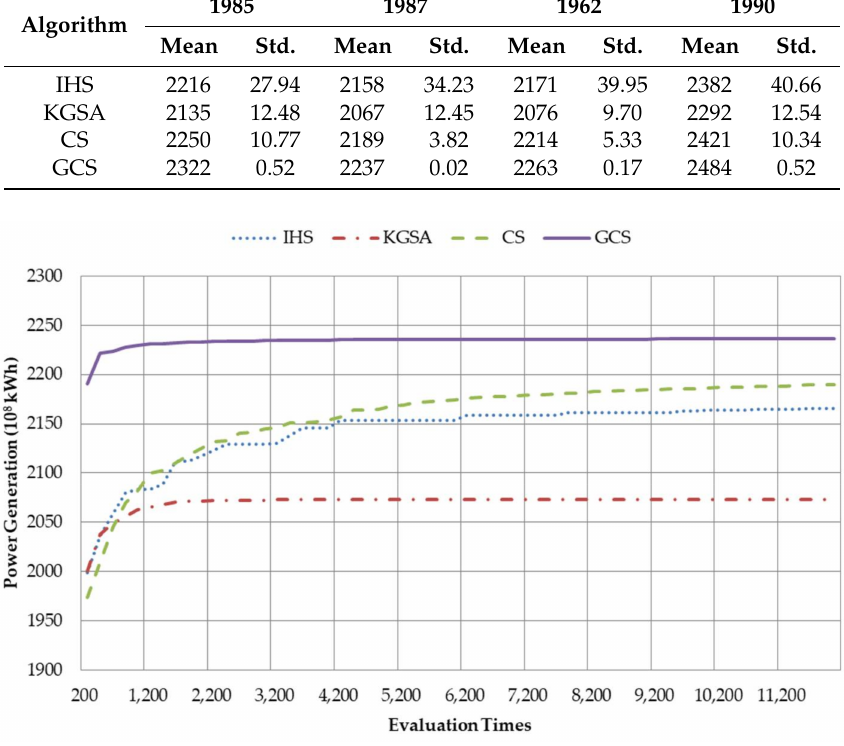
Figure 7. Convergence process of the algorithms in the year